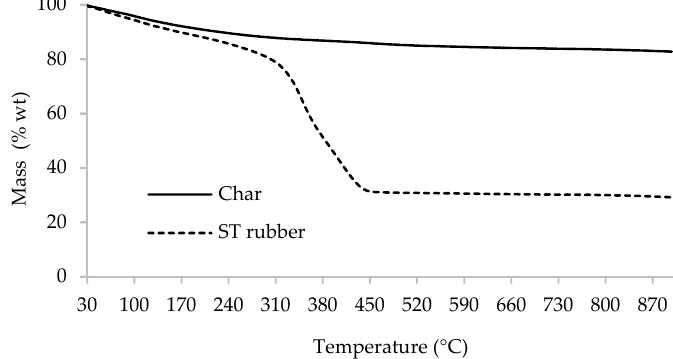
Figure 2. The TGA curves for both spent tire (ST) rubber and char samples.